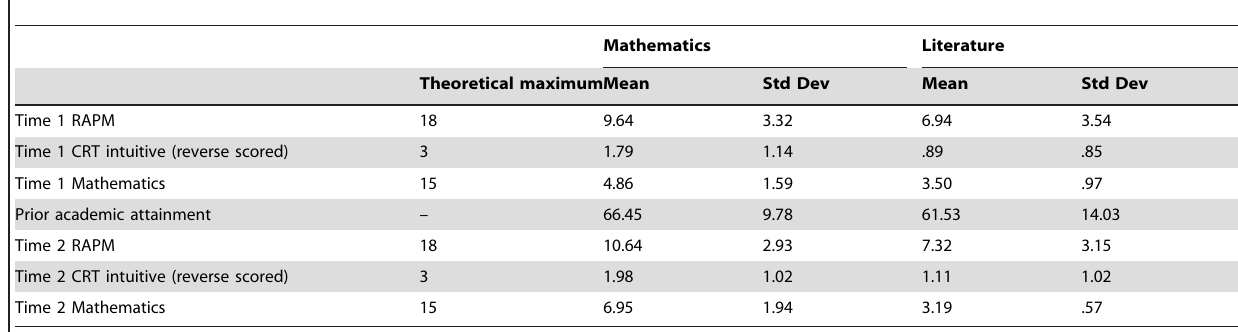
Table 3. Means and standard deviations for measures of covariates and mathematical achievement.